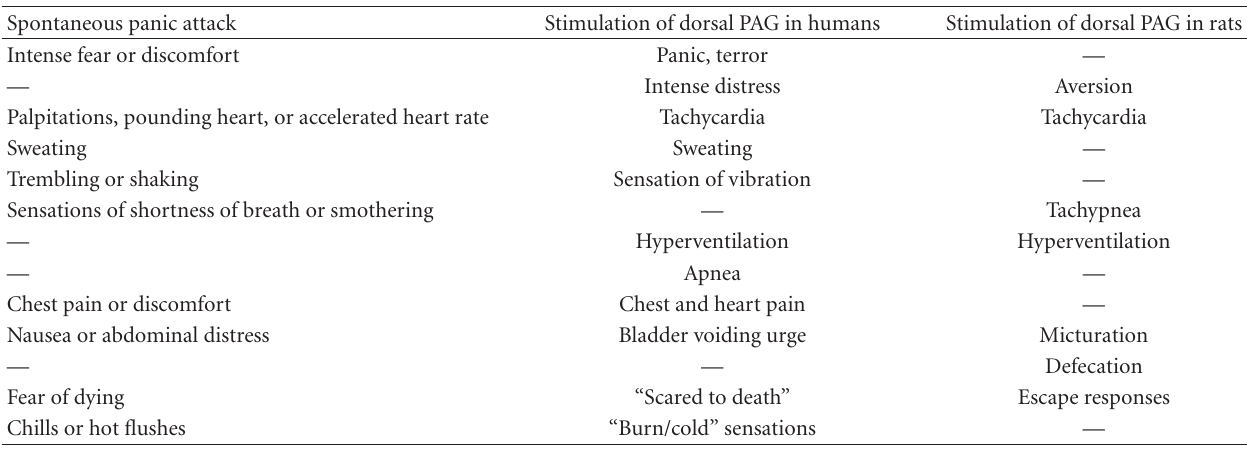
Table 1: Phenomenological similarities between panic attacks and e ff ects of electrical stimulation of the periaqueductal gray matter (PAG) in humans and rats. Adapted from Jenck et al. [11] and Schenberg et al. [12].